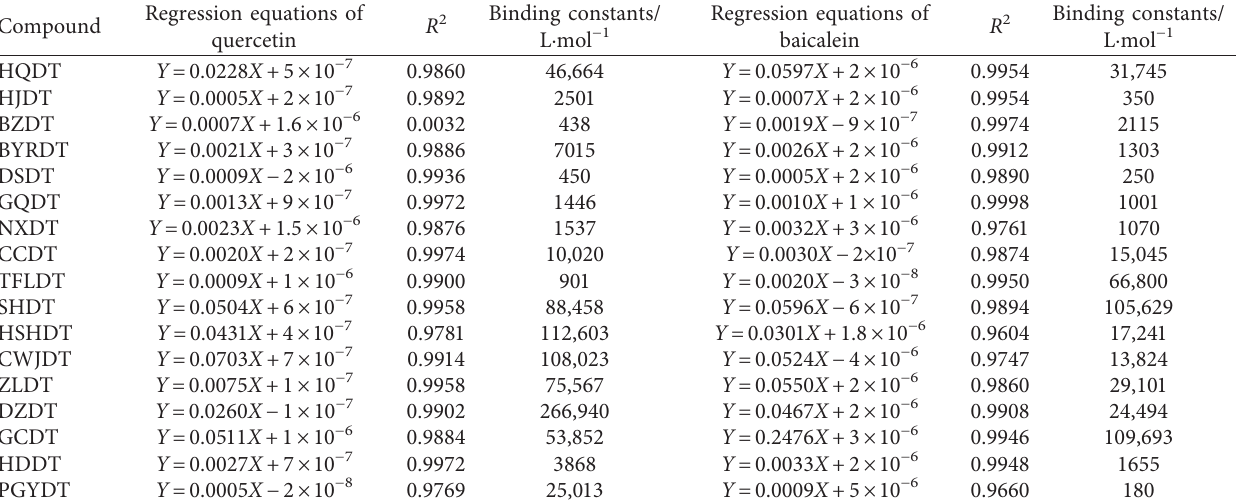
Table 4: Regression equations, correlation coefficients ( r ), and binding constants of phase-solubility of the polysaccharides with quercetin and